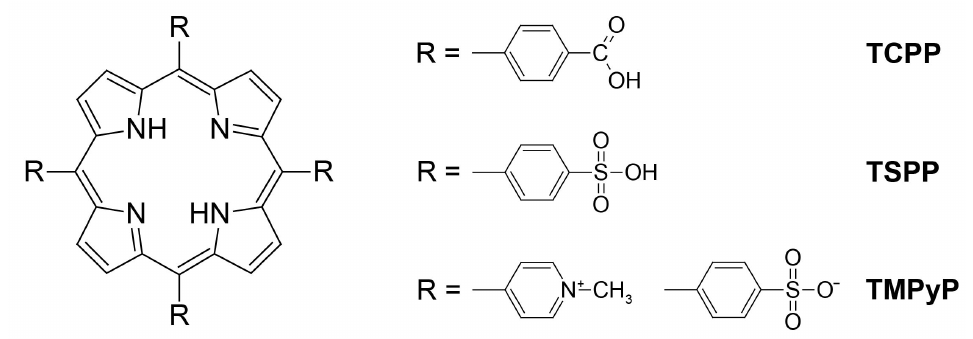
Figure 1. Structures of studied porphyrins.